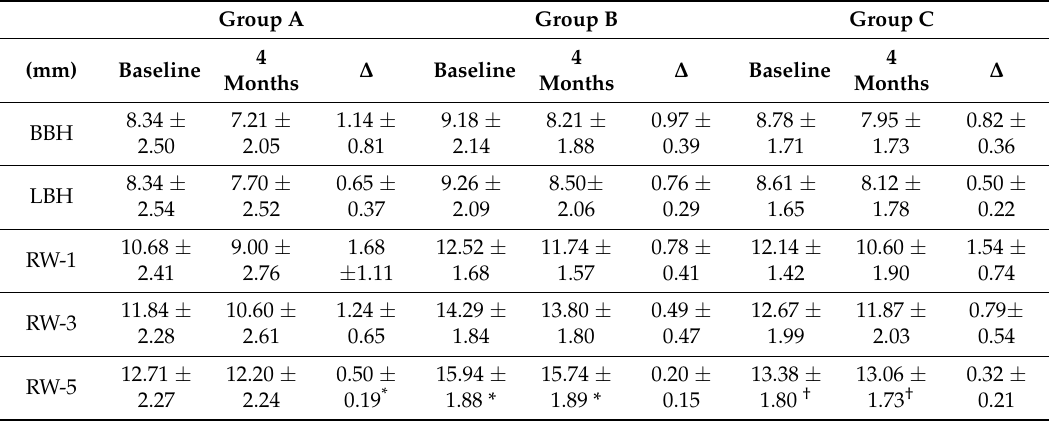
Table 3. Alveolar bone heights and widths in the three groups (A, B, and C) at baseline and 4 months following ridge preservation.